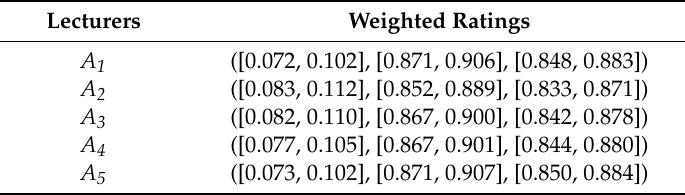
Table 3. Average weighted ratings of